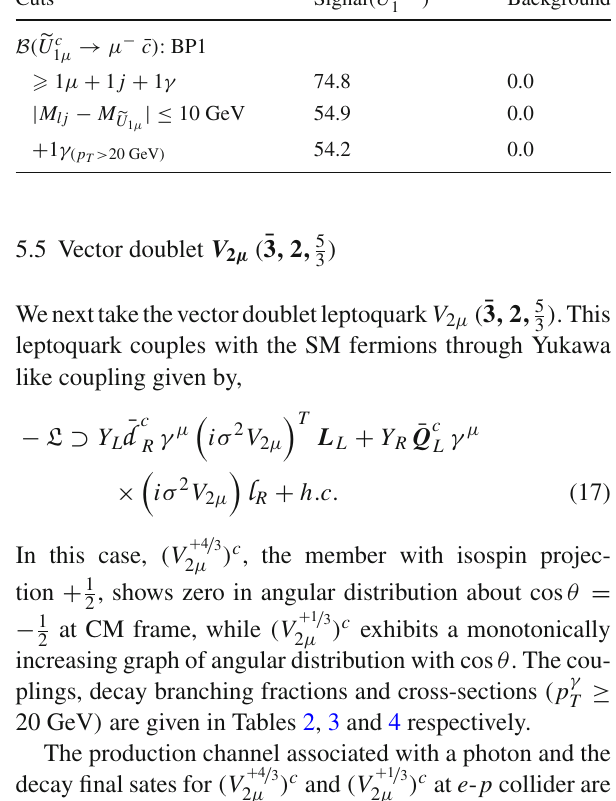
√ s = 318 GeV and L int = 100 fb − 1 at with 1 μ / 3 ) c Background 1